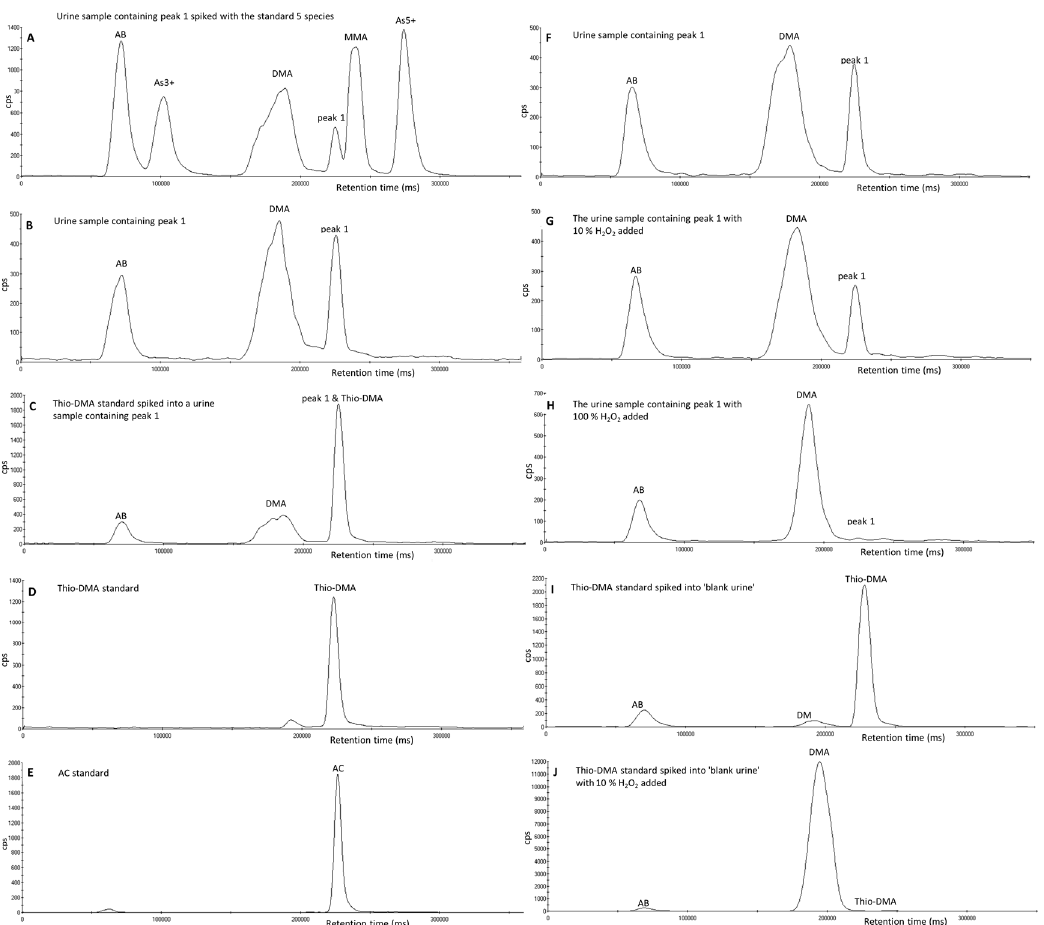
Figure 2. Chromatograms of arsenic species analyzed using an ESI OneFAST system coupled to a Dionex AG7 anion exchange column and ICP-MS using mobile phases 2 mM and 70 mM ammonium carbonate solution. ( A ) A urine sample containing peak 1 spiked with a 20 µ g · L − 1 solution of the standard five species. ( B ) An unspiked urine sample containing peak 1. ( C ) The urine sample containing peak 1 spiked with an approximate concentration of 40 µ g · L − 1 thio-DMA standard. ( D ) A thio-DMA standard at an approximate concentration of 40 µ g · L − 1 and ( E ) A 5 µ g · L − 1 AC standard. ( F ) The urine sample containing peak 1. ( G ) The urine sample with 10% v/v H2O2 added ( H ) The urine sample with 100% H 2 O 2 added ( I ) Thio-DMA standard spiked into ‘blank urine’ not containing peak 1 ( J ) The spiked urine sample from chromatogram D with 10% v/v H 2 O 2